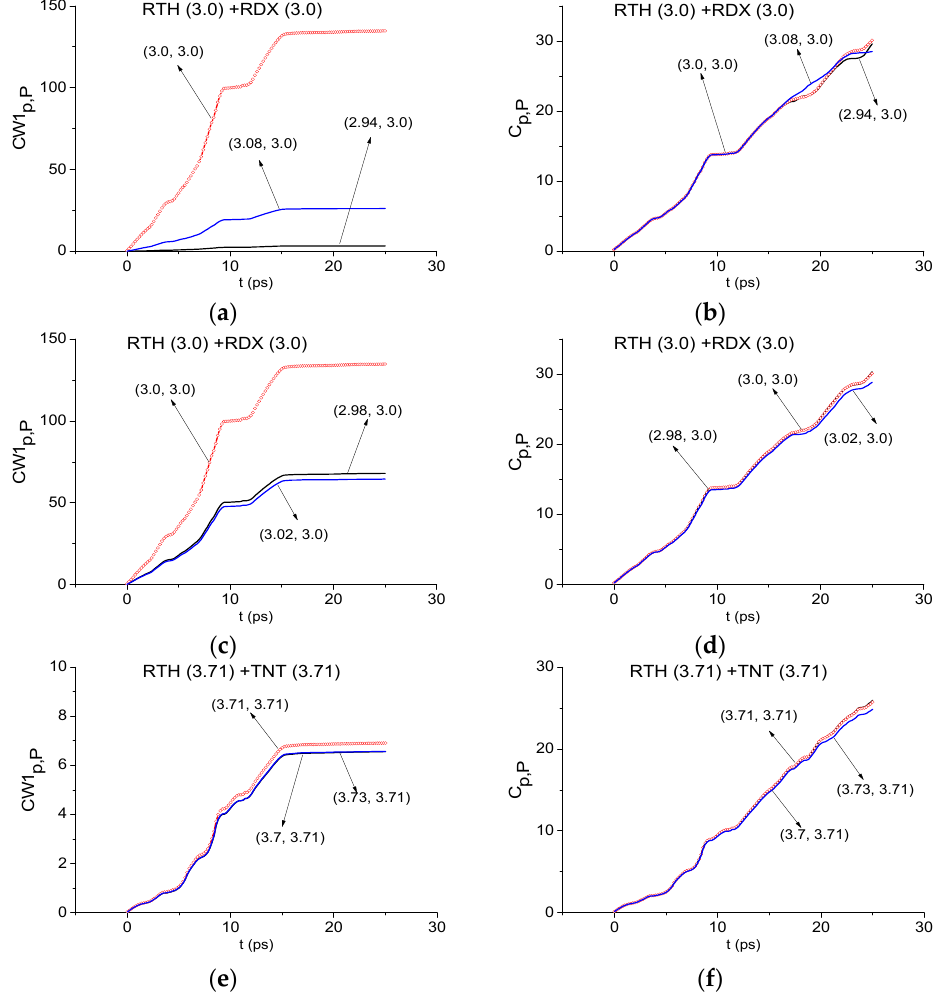
Figure 12. Time-dependent ICC CW 1 p , P (a,c,e) and C p , P ( b,d,f ) computed at the frequencies ν = 3.0 THz ( a–d ), 3.71 THz ( e,f ) using the FDRs ν = [2.94, 3.08] THz ( a,b ), [2.98, 3.02] THz ( c,d ), and [3.7, 3.73] THz ( e,f ).